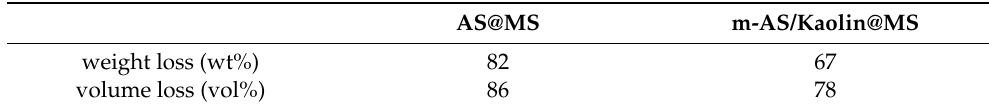
Table 1. Weight loss of the AS@MS and m-AS/Kaolin@MS samples during the carbonization at 500 ◦ C for 4 h.